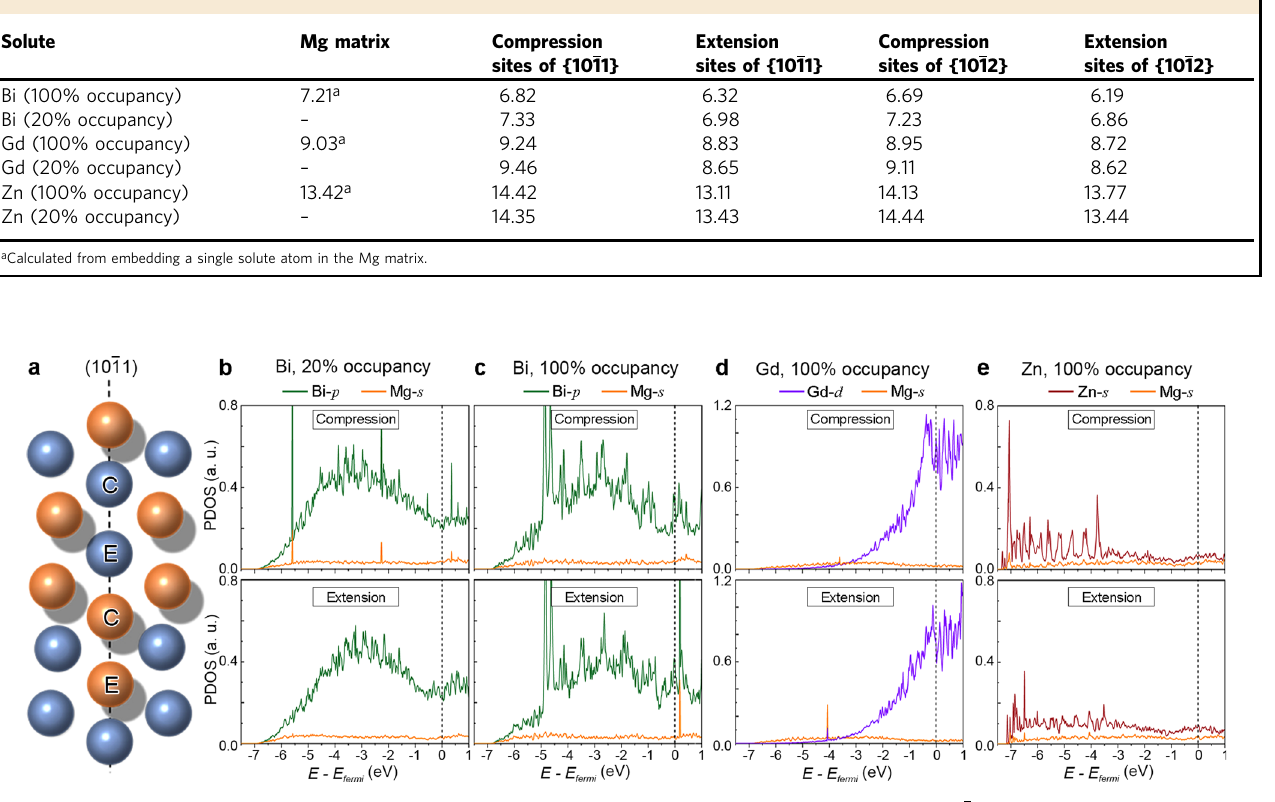
Fig. 5 Site geometry and plots of the partial density of states (PDOS). a Atomic arrangement of atoms at the {1011} CTB. Atoms labeled C show the compression site, and E denotes the expansion site. The orange and blue colors are used to denote atoms in different layers along [1210]. b – e PDOS for the cases where solute atoms segregated into the compression site or extension site of {1011} CTB: b Bi segregation with 20% occupancy, c Bi segregation with 100% occupancy, d Gd segregation with 100% occupancy, and e Zn segregation with 100% occupancy. The energies of states have been adjusted so that the Fermi level sits at 0 eV. The unit of PDOS in ( b – e ) is an arbitrary unit (a.